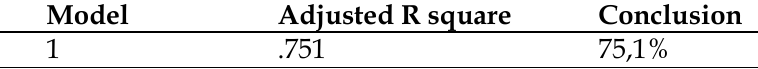
Table 6. Determination